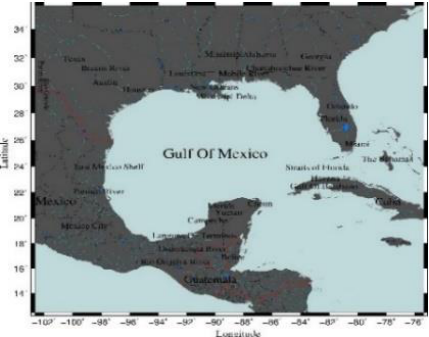
Figure 1. The Gulf of Mexico.